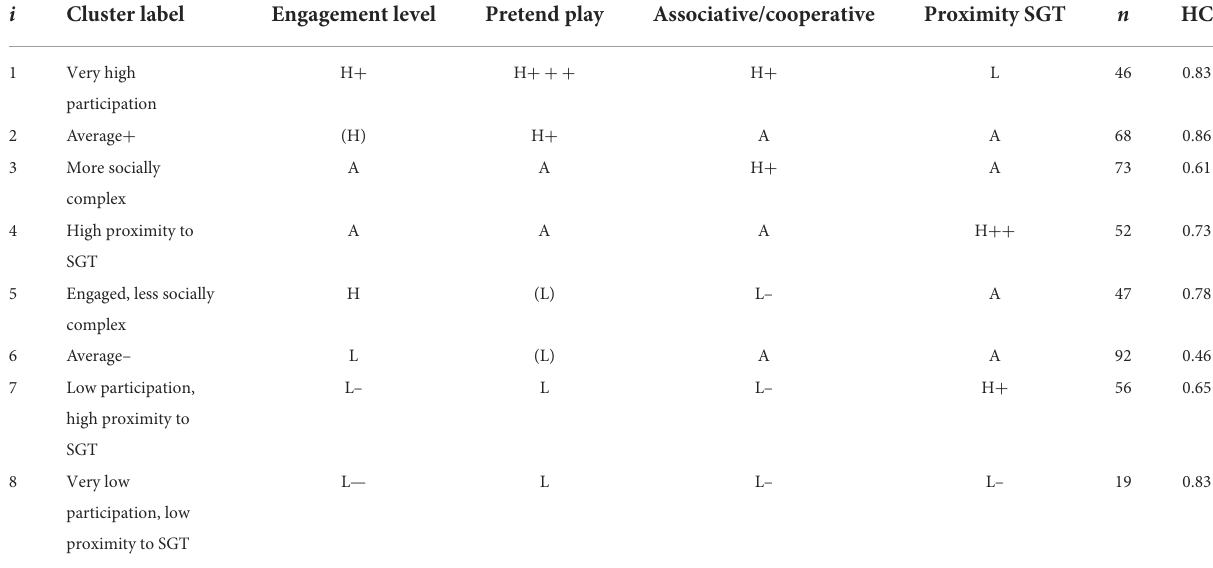
TABLE 3 Patterns of observed level of engagement, pretend play, associative/cooperative interactions, and proximity to a small group including teachers in preschool free play ( N = 453). i Cluster label Engagement level Pretend